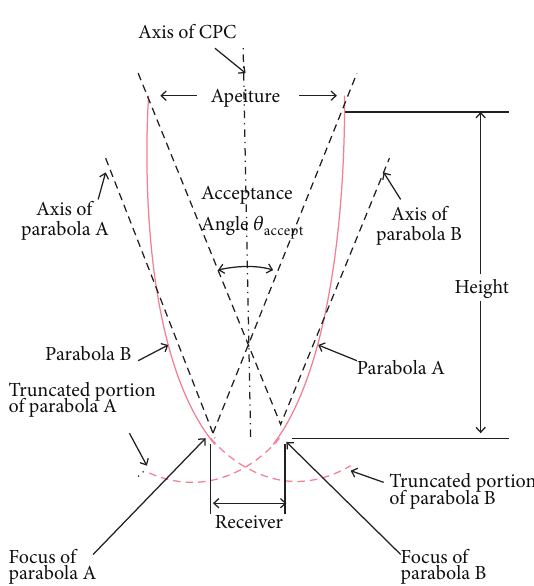
Figure 4: Cross section of a nontruncated CPC